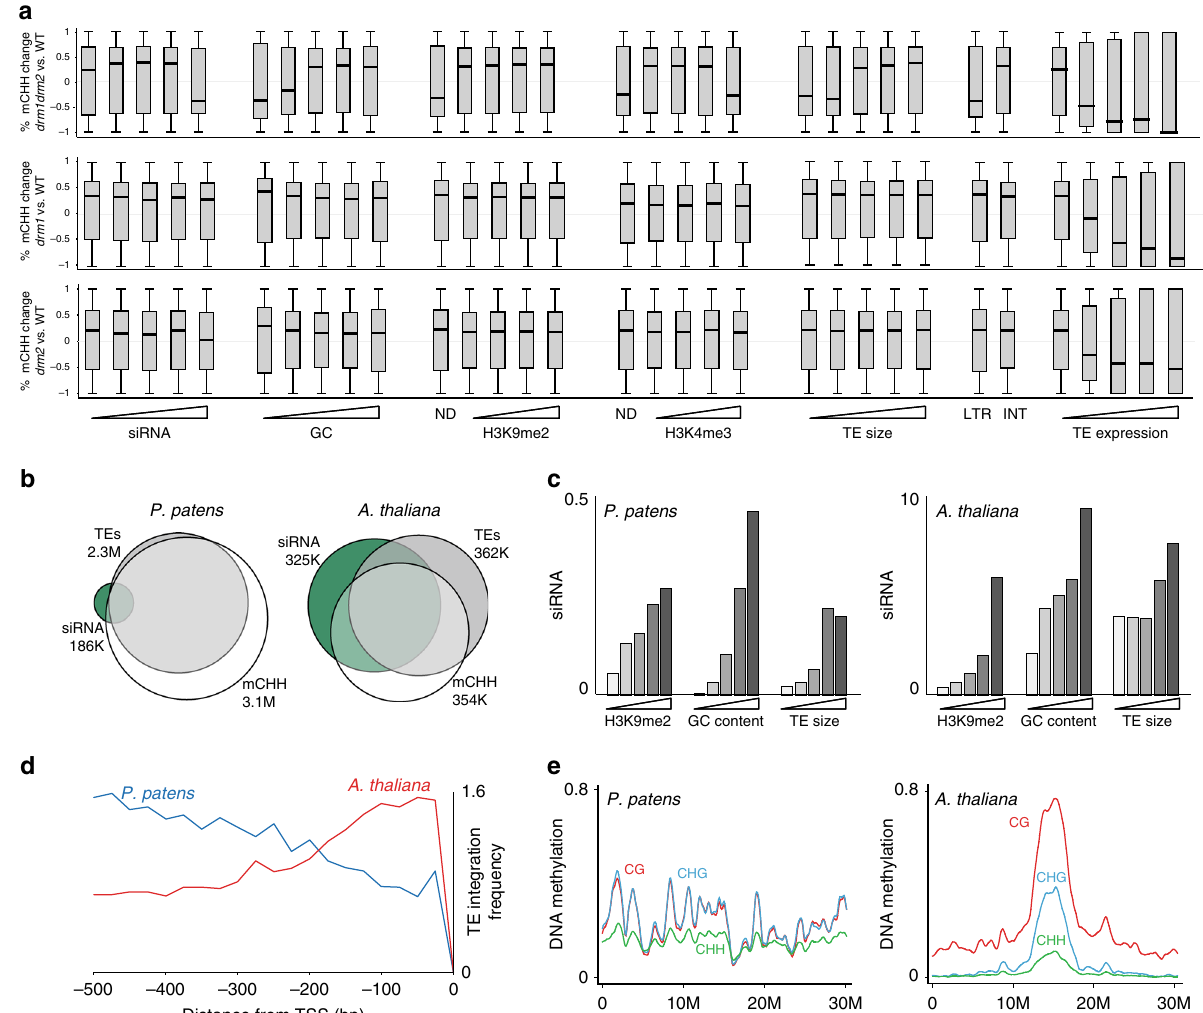
Fig. 4 PpDRMs methylate active-euchromatic TEs. a Box plots of percent-methylation-change between indicated samples within differentially CHH methylated 50 bp windows, separated based on the level of various genomic/chromatin attributes. Note the hypo-methylation trend in protonema drm1drm2 sample (top track) in genomic regions with high siRNA counts, low GC content, absent H3K9me2 signal, high H3K4me3 signal, short TEs, LTR annotations, and TE expression. b Venn diagram showing abundance and overlap between siRNA, CHH methylation, and TE annotation, in Arabidopsis and P. patens . c siRNA abundance over increased quantiles of indicated chromatin features in A. thaliana ( c ) and P. patens ( c ). d Patterns of TE integration in Arabidopsis and P. patens upstream to gene TSS. Arabidopsis or P. patens genes were aligned at the 5 ′ end (0 at x axis) and percentage of the number of TEs ( fi rst and closest nucleotide of TE to TSS) within each 25 bp is plotted. e LOWESS fi t of DNA methylation distribution averaged in 100 kb bins across chromosome 1 in Arabidopsis and P.